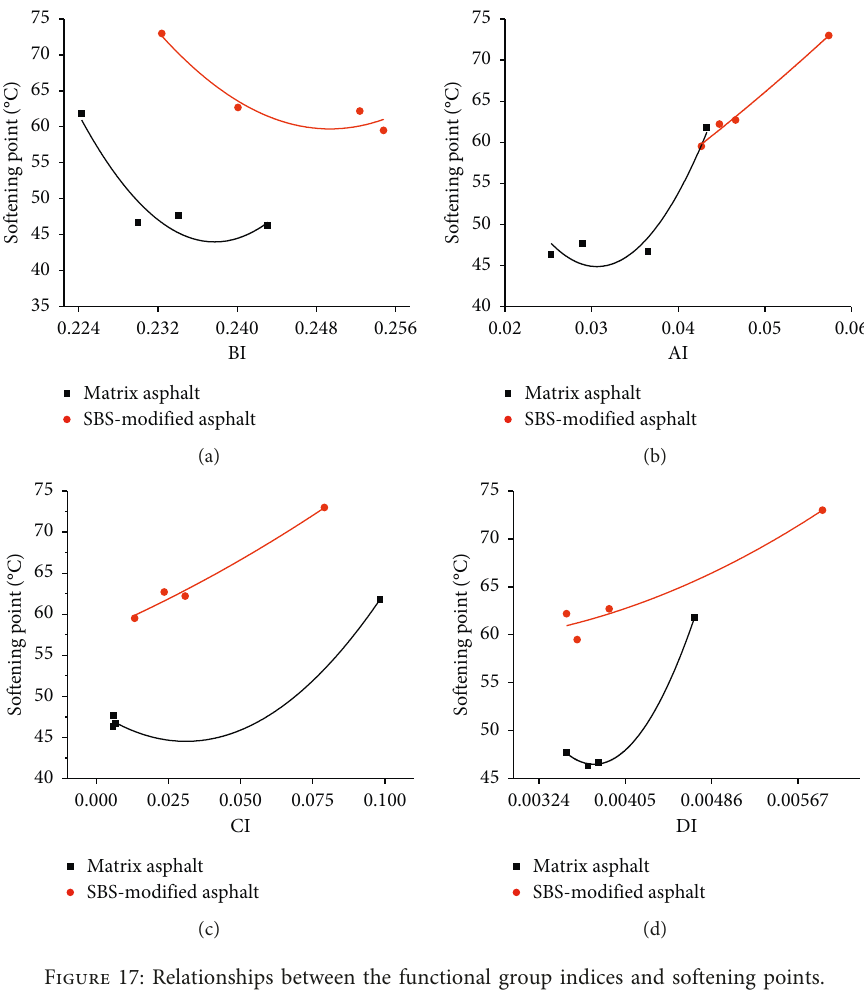
Figure 17: Relationships between the functional group indices and softening points.